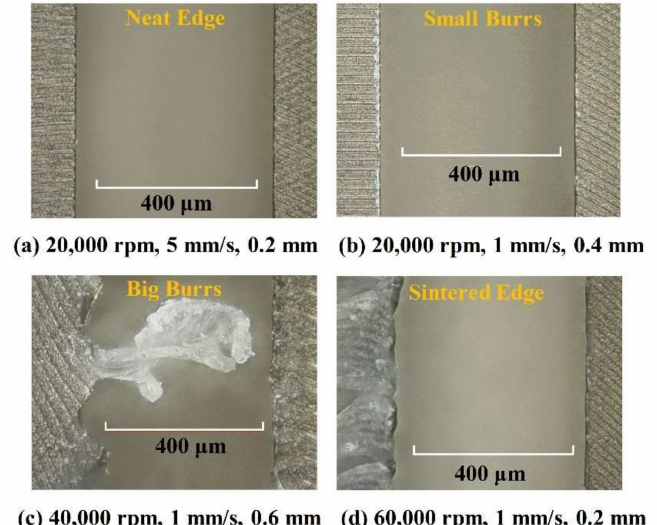
Figure 7. Grove edge morphology classification. The grooves were machined by di ff erent processing parameters, spindle speed-feed rate-cutting depth: ( a ) 20,000 rpm, 5 mm / s, 0.2mm; ( b ) 20,000 rpm, 1 mm / s, 0.4 mm; ( c ) 40,000 rpm, 1 mm / s, 0.6 mm; ( d ) 60,000 rpm, 1 mm / s, 0.2 mm. (The results were measured by the laser scan confocal microscope (VK-X250, Keyence Co., Osaka, Japan) with a 10 × microscope lens).